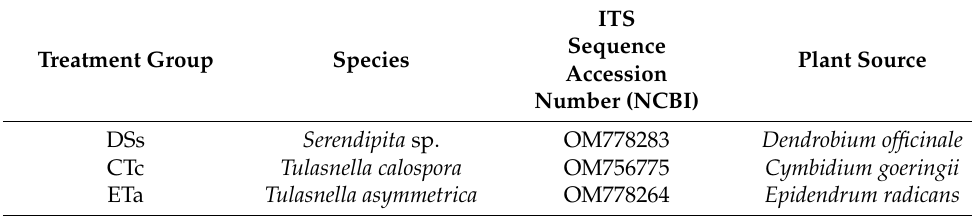
Table 1. Sources of the fungal samples from which the samples were